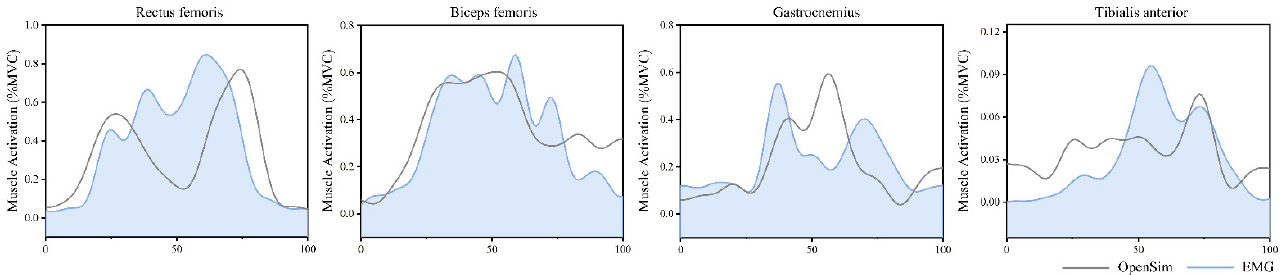
Figure 2. The results of rectus femoris, gastrocnemius, long biceps femoris, and anterior tibialis activation levels obtained using the EMG signal and the OpenSim optimization algorithm were more consistent.